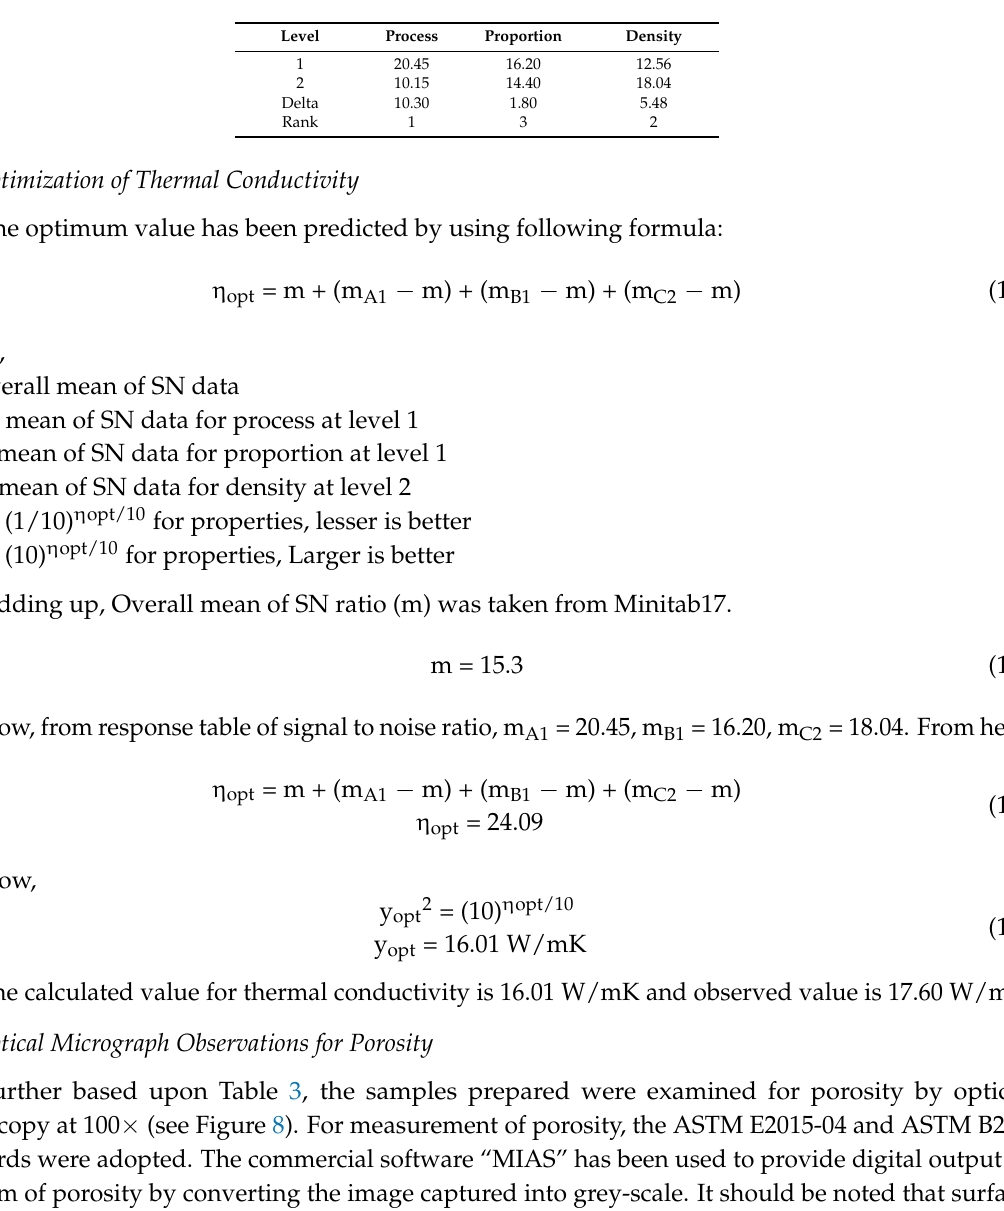
Table 9. Ranking of input process parameters for thermal